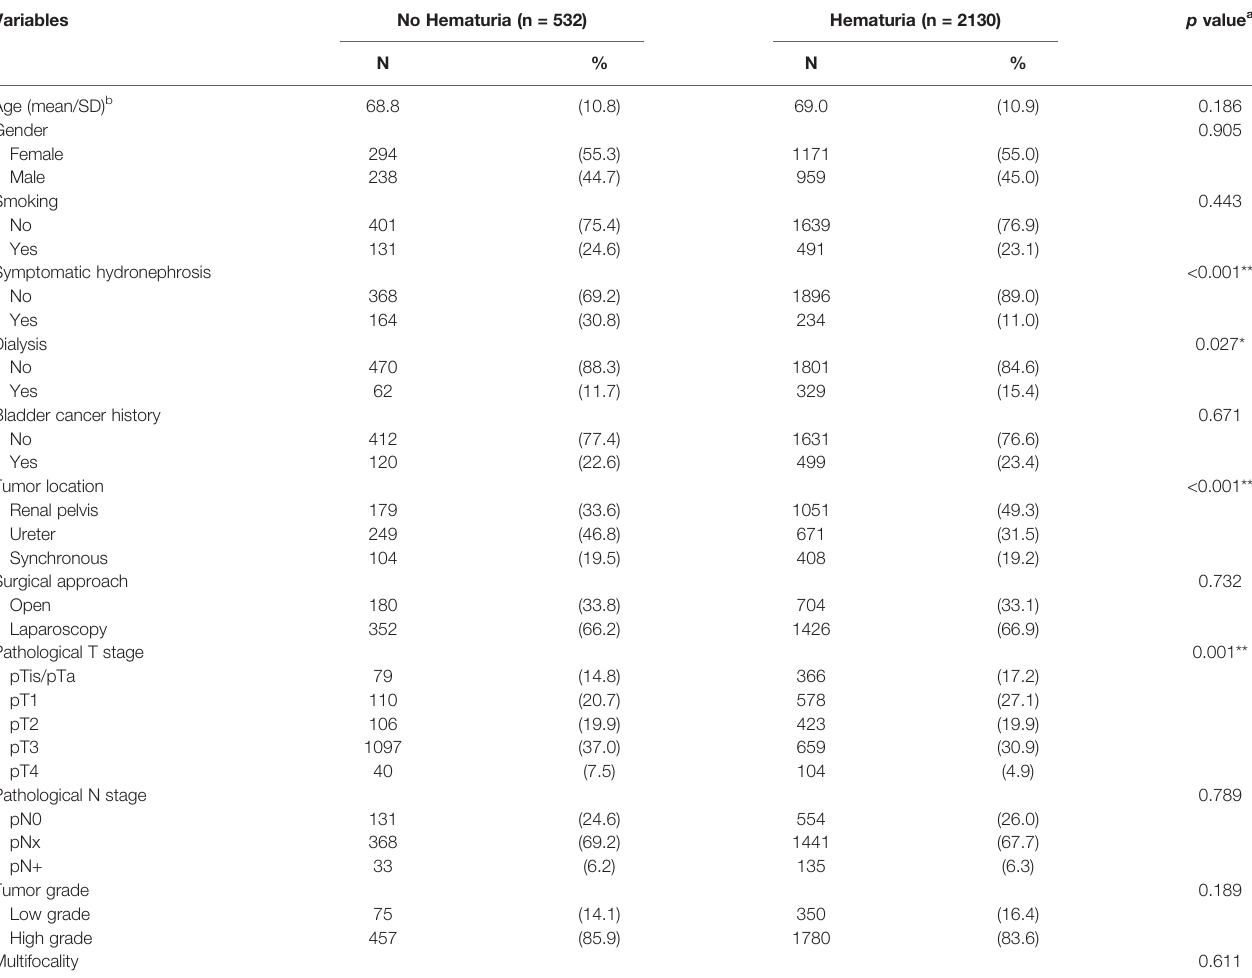
TABLE 1 | Clinicopathological data of UTUC patients according to hematuria.